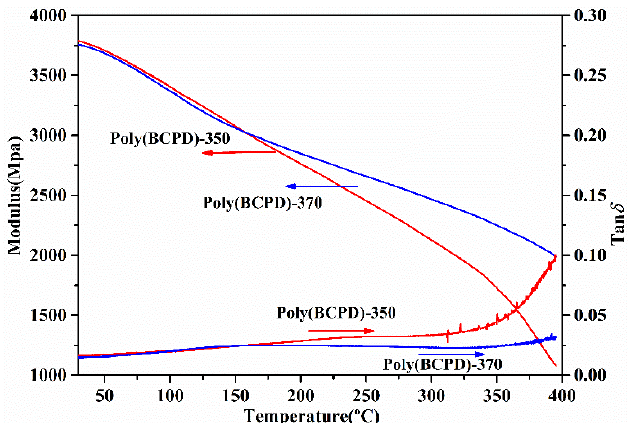
Figure 11. DMA curves of the poly(BCPD) resins.